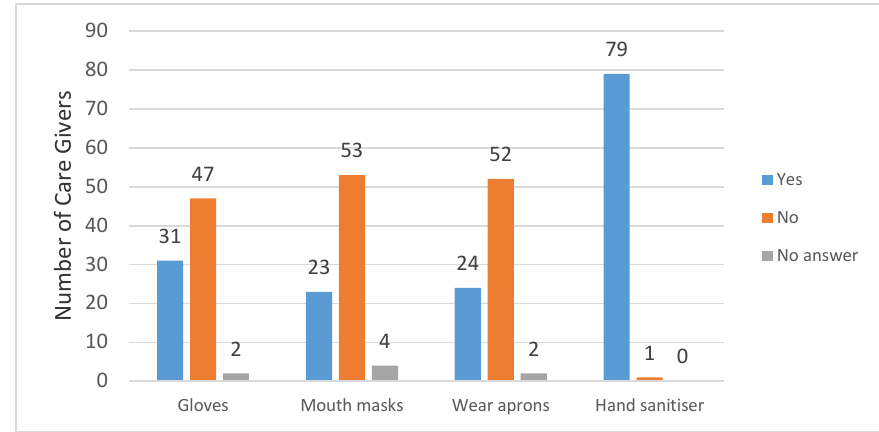
Figure 1. Use of protective gear by caregivers.